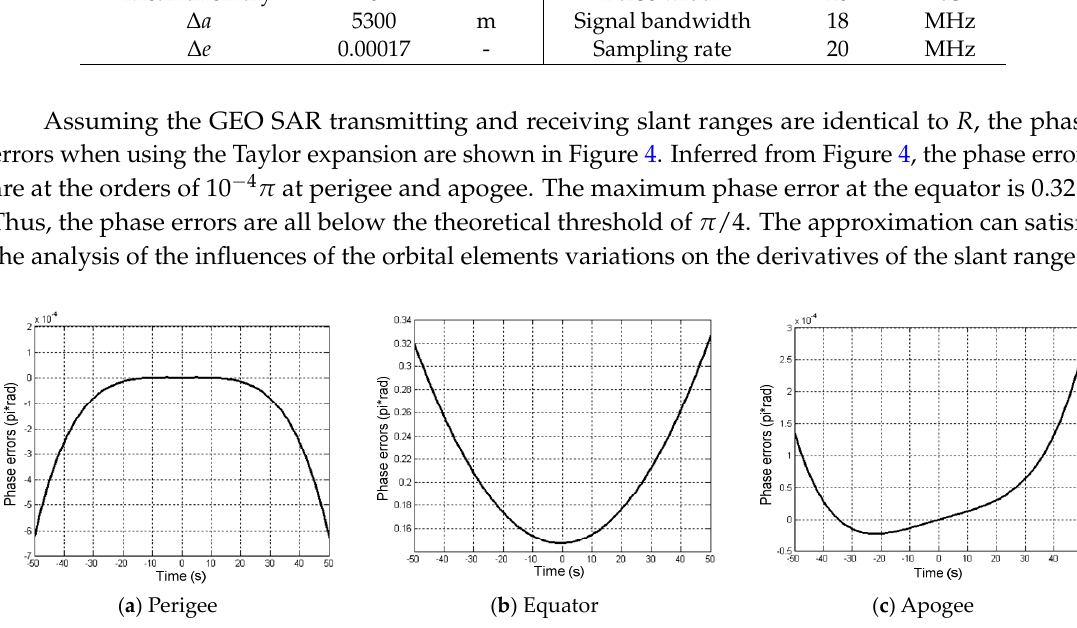
Figure 4. Phase errors of the Taylor expansion approximation to the ideal GEO SAR slant range.